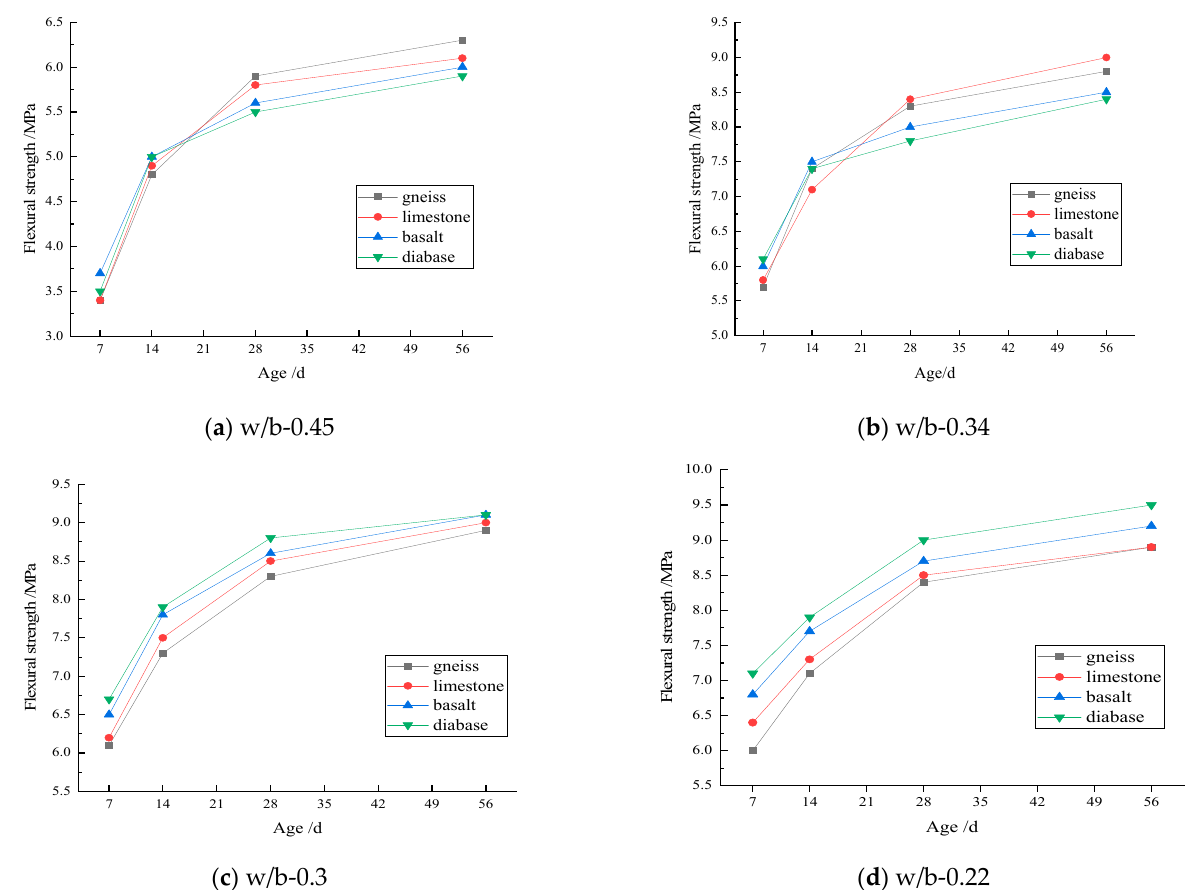
Figure 6. The flexural strength of concrete with different types of coarse aggregate: ( a ) water-binder ratio of 0.45; ( b ) water- binder ratio of 0.34; ( c ) water-binder ratio of 0.30 and ( d ) water-binder ratio of 0.22.